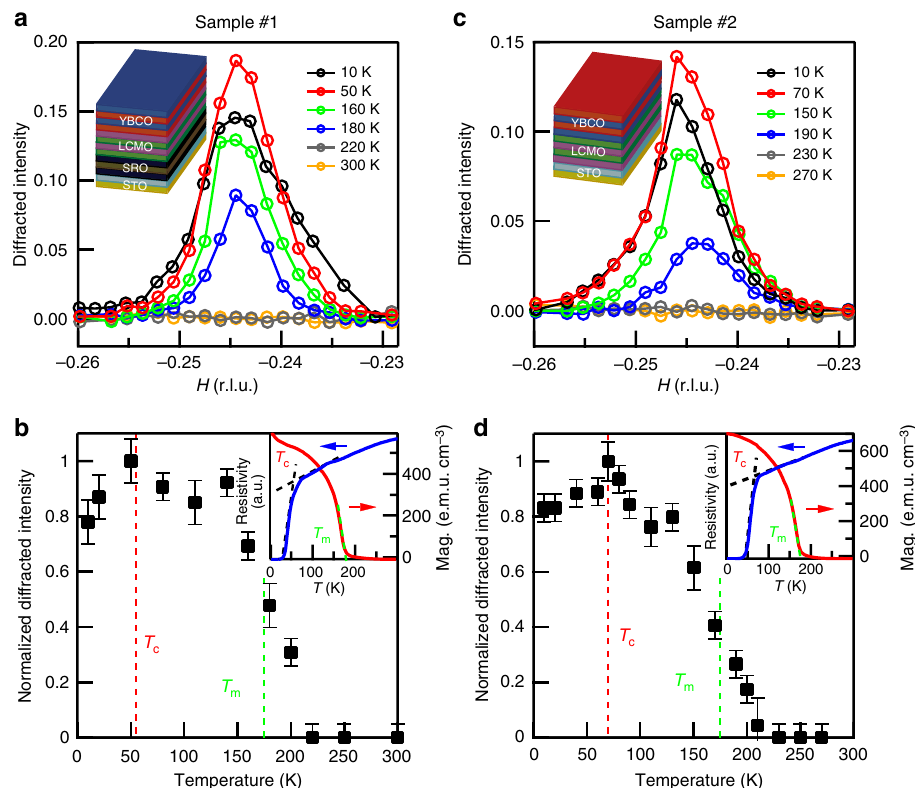
Figure 3 | Temperature evolution of the electronic supermodulation. ( a ) Diffracted intensity of a line cut along H measured at resonance (930.85eV) on sample #1 at selected temperatures at fixed L ¼ 1.38 and K ¼ 0. ( b ) Temperature dependence of the peak intensity (normalized to the maximum value) in a . Red (green) dashed line marks T c ( T m ) determined from the resistivity (magnetization) measurement shown in the insets. ( c , d ) Results of sample #2. The diffracted intensity in a and c share the same scale as before. ( a , c ) Inset: schematics of the heterostructure for samples #1 and #2, respectively. Error bars reflect the uncertainty due to mean-square deviation in determining the diffraction peak intensity based on curve fitting. r.l.u., reciprocal lattice